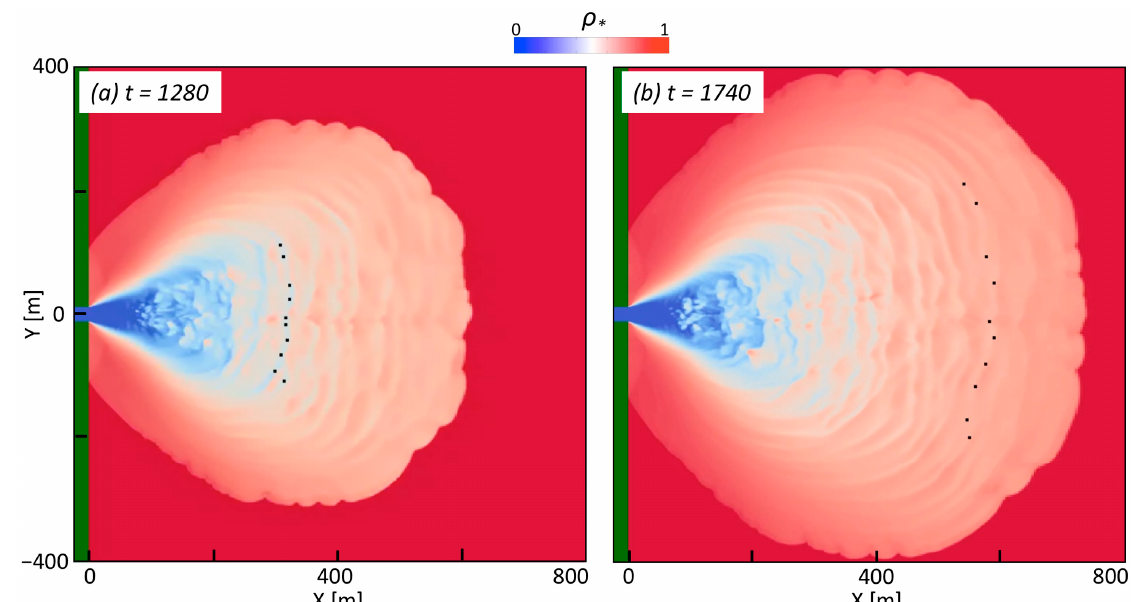
Figure 4. Advection of surface water particles (black dots) chosen to lie initially within a ring feature. ( a ) Initial density field, t = 1280 s; ( b ) 7.7-min later, t = 1740 s. The ten initial particle positions were determined from local density minima within a specified subset area; subsequent particle positions were determined by computing their Lagrangian displacements, using the evolving surface velocity field at each model time step ( ∆ t ~ 0.14 s). For clarity, the particles are shown larger than the underlying model cell dimension. An animation (Figure S1) shows particle positions every 10 s over the time period of ( a ) to ( b ). Remote Sens. 2020 , 11 , x FOR PEER REVIEW Rings move continuously offshore and toward the plume front. This is illustrated